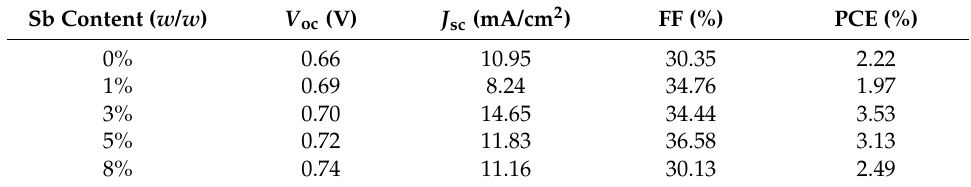
Figure 4. J – V characteristics of FTO/ZnO/Sb:TiO 2 /CdTe/Au with dopant concentration ( a ) under light and ( b ) EQE properties of devices. Table 2. Summarized performances of CdTe–TiO 2 heterojunction solar cells with dopant concentration. Sb Content ( w / w